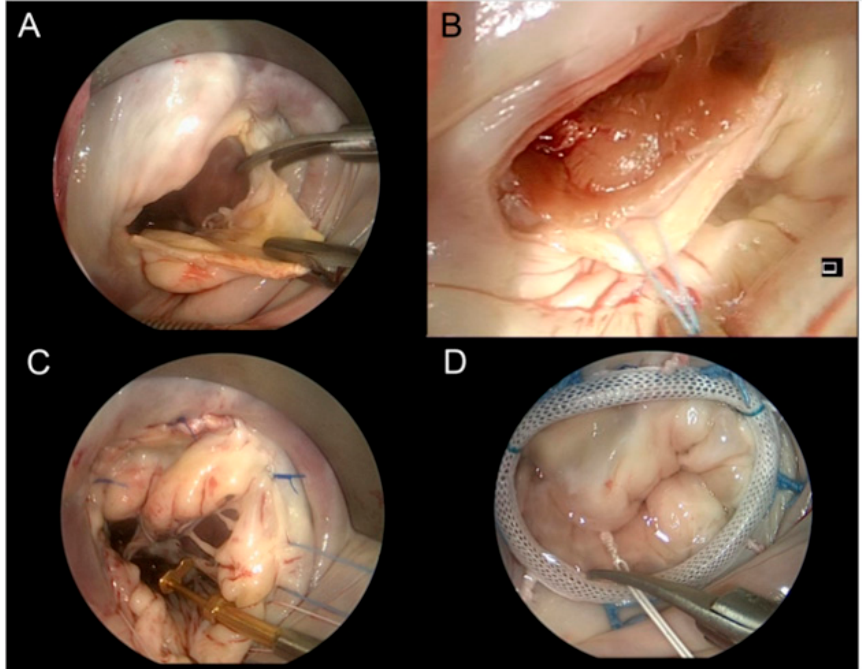
Figure 5. Minimally invasive HOCM surgery. Transmitral SM. Incision at the base of mitral leaflet ( A ); pull back suture placement to facilitate SM ( B ); mitral valve repair with loop-technique ( C ); completed mitral valve annuloplasty ( D ) concomitant to LVOTO